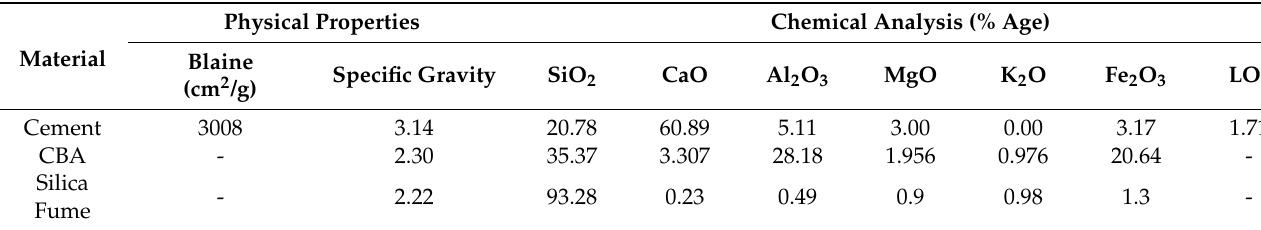
Table 2. Concrete mix proportion.